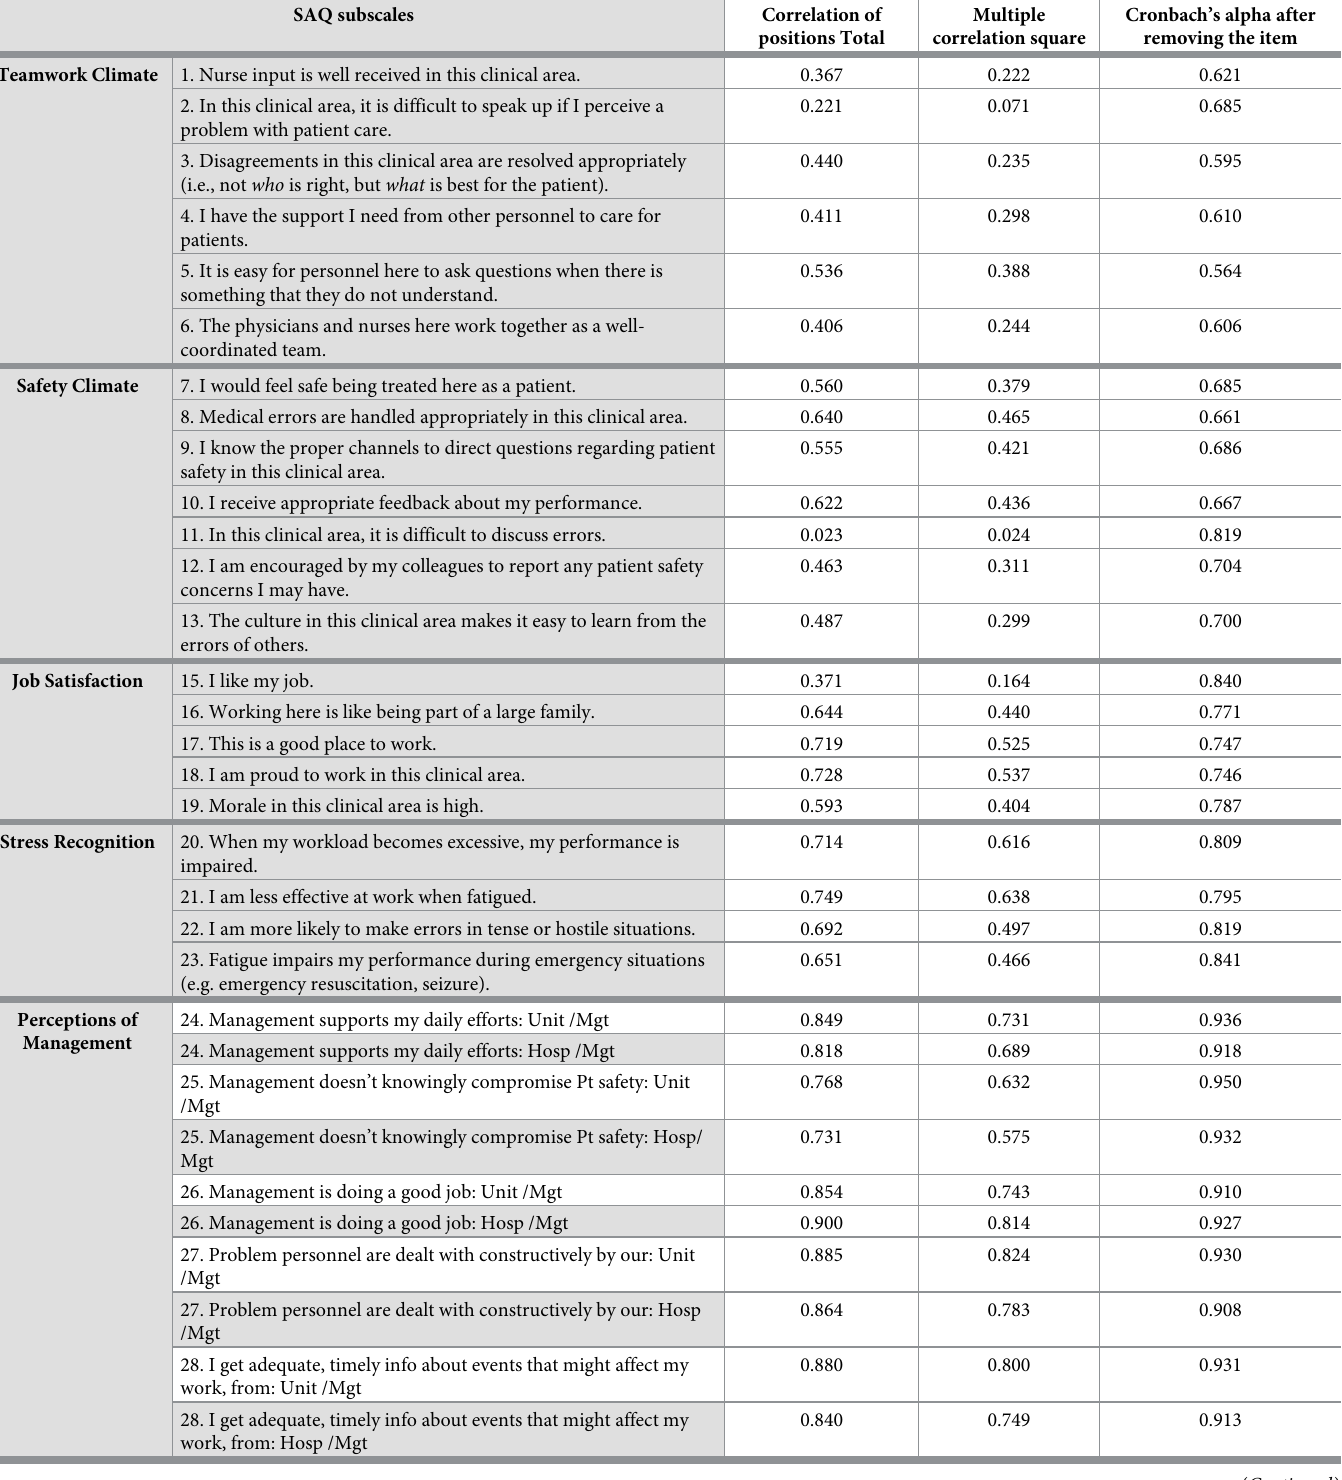
Table 4. Discriminatory power of SAQ-SF scales.